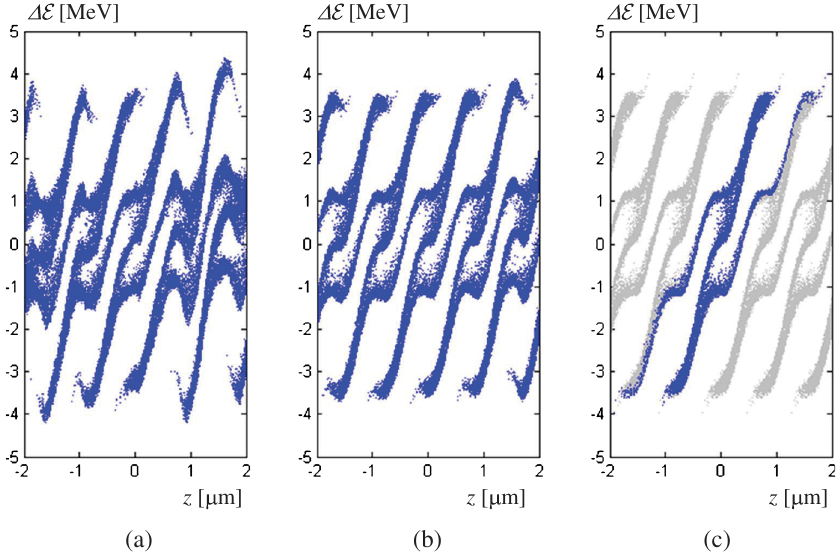
FIG. 12. Application A: longitudinal phase space 15 m behind chicane 3. (a) Calculated with QField-non-periodic, one million macro- particles, 30 fs (FWHM) laser modulation, (b) calculated with QField-non-periodic, 20 million particles, 60 fs (FWHM) laser modulation, (c) calculated with